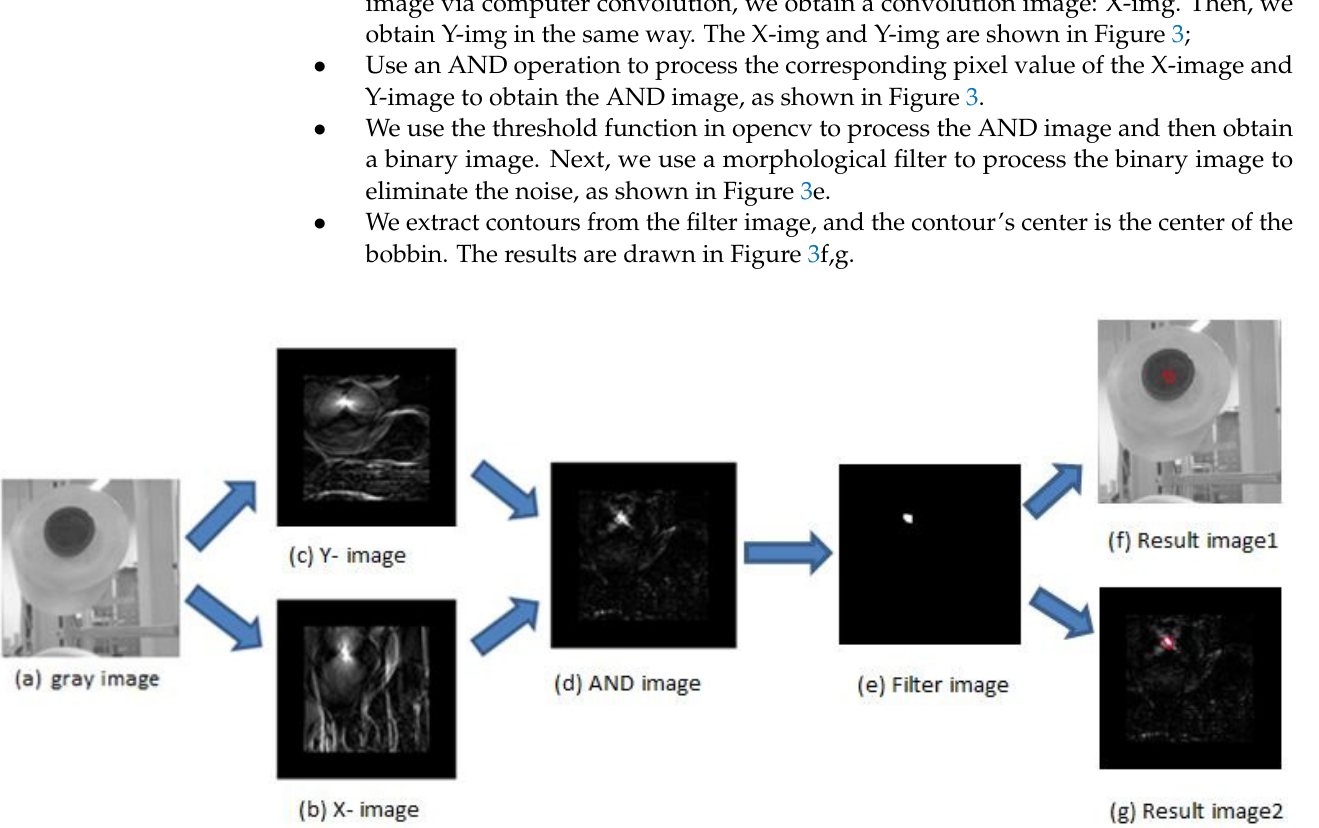
Figure 3. Convolution image, ( a ) is gray image. ( b ) is X-image. X-image is the grayscale image convoluted with circle_x. ( c ) is Y-image. Y-image is the grayscale image convoluted with circle_y. ( d ) is the AND image. The AND image is obtained by operating the AND operation between the X-image and Y-image. ( e ) is the filter image. The filter image is obtained by threshold and eroding and dilatinge the AND image. Lastly, we draw the detected center (red circle) of the bobbin in ( f ) and ( g ).